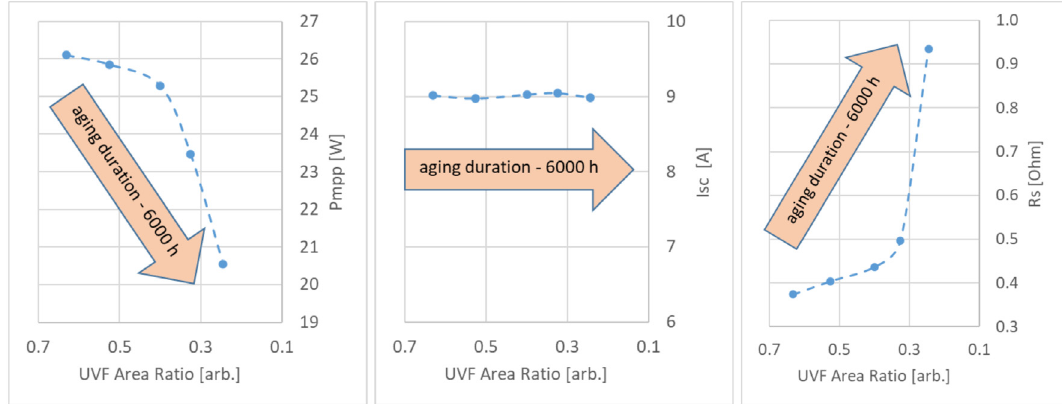
Fig. 7. Correlation of electrical parameters and UVF area ratio for Tropical 1 (85 ° C, 85% r.H.).